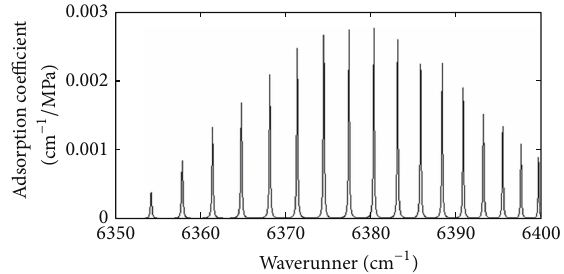
Figure 5: The characteristic absorption lines of CO in the spectral range of 6350 ∼ 6400 cm −1 .